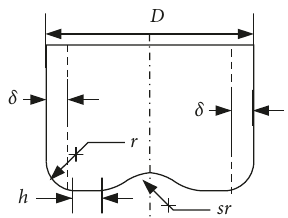
Figure 3: Geometry of the model electrode.